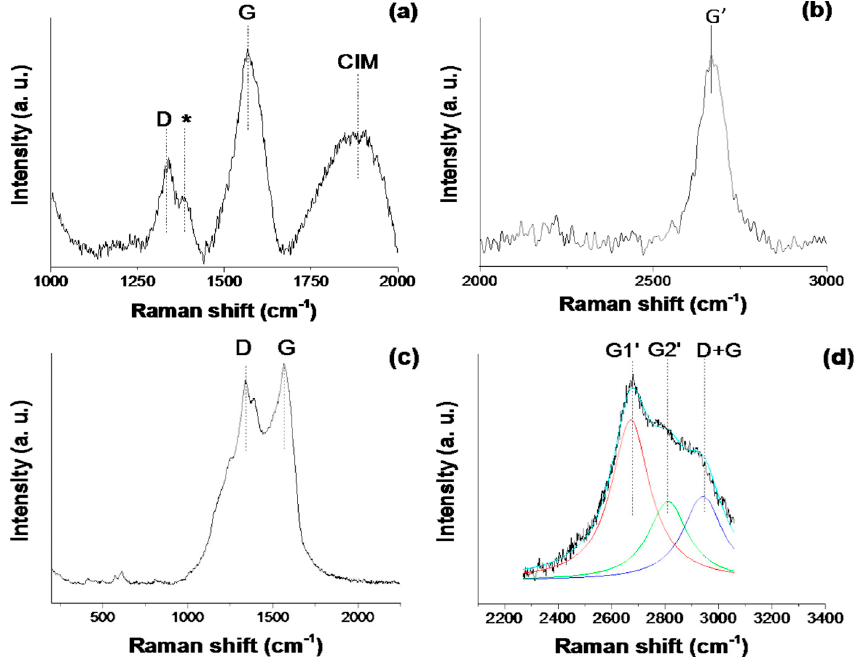
Figure 1. Raman Spectra of IC/PANI/MWCNT (ICPM) metacomposite before ( a , b ) and after ( c , d ) plasma treatment.